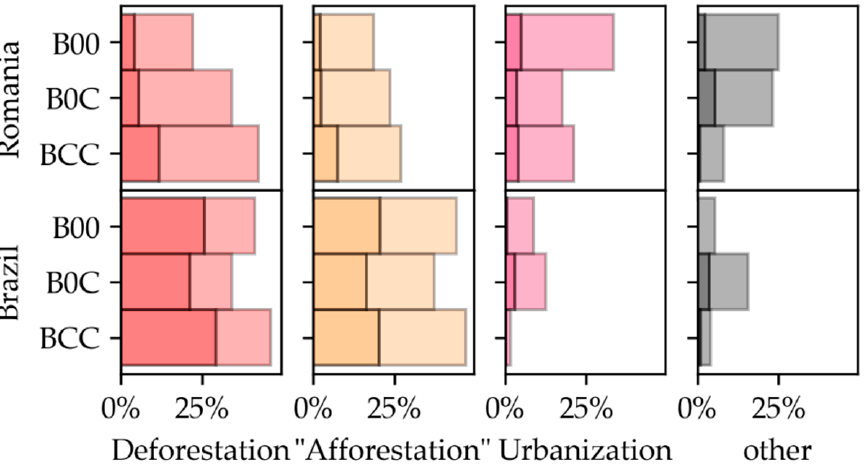
Figure 13. Contribution of each specific change type disaggregated by site. The paler bar indicates small-sized changes that would be lost after a single pass of the morphological operator “opening” (i.e., lone misclassified pixels). The darker bars indicate changes that were larger and would not be lost (i.e., bigger change patch).